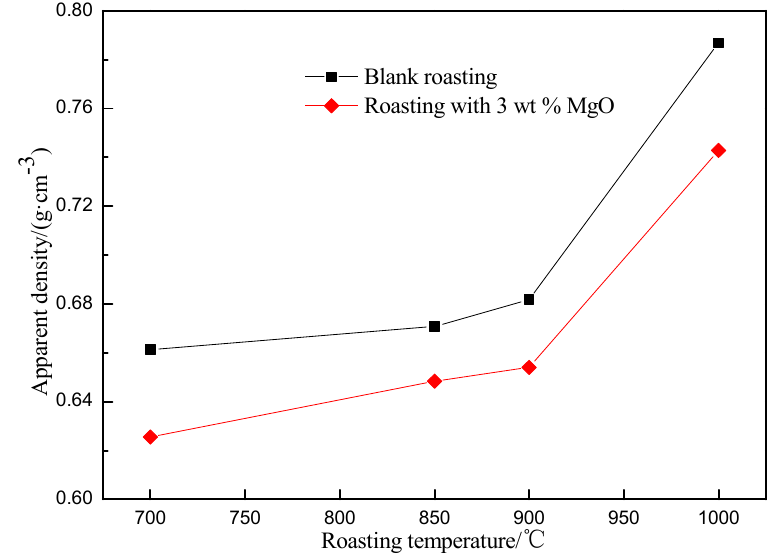
Figure 9. Apparent density of the roasted samples at different roasting temperatures.